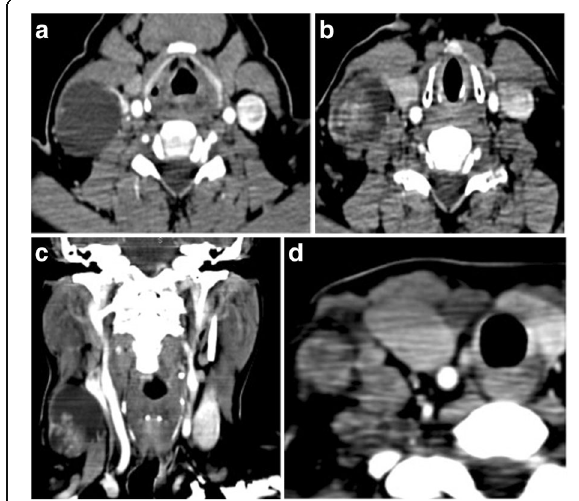
Fig. 3 A 34-years-old man with cystic node on right side: ( a ) showing homogenous cystic node as coined in our study ( b ) showing moderately hyper-enhancing nodules (yellow arrow). Both nodal components are shown in the coronal image in ( c ) and a necrotic node is seen at level IV at ( d ). Imaging suggested non- squamous cell carcinoma metastatic node and thyroid primary highly suspected though not shown at all on computed tomography. Ultrasound-guided biopsy confirmed papillary thyroid carcinoma